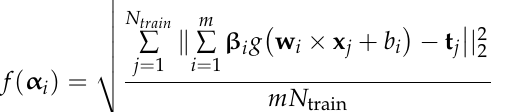
Table 1. Parameters of BSM1.